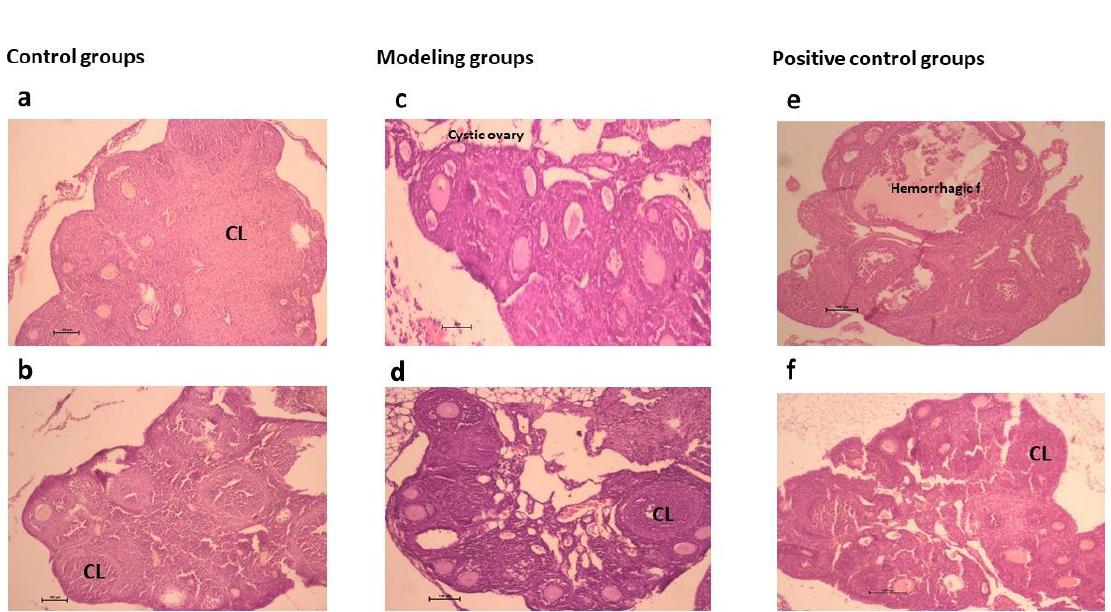
Figure 3: Histological sections of ovarian tissues of the treated groups in comparison with the control groups assessed by Hematoxylin and Eosin staining method (H&E): Grouping as follows: ( a ) control, ( b ) minocycline control, ( c ) PCOS model, ( d ) PCOS minocycline, ( e ) PCOS letrozole, ( f ) PCOS met-